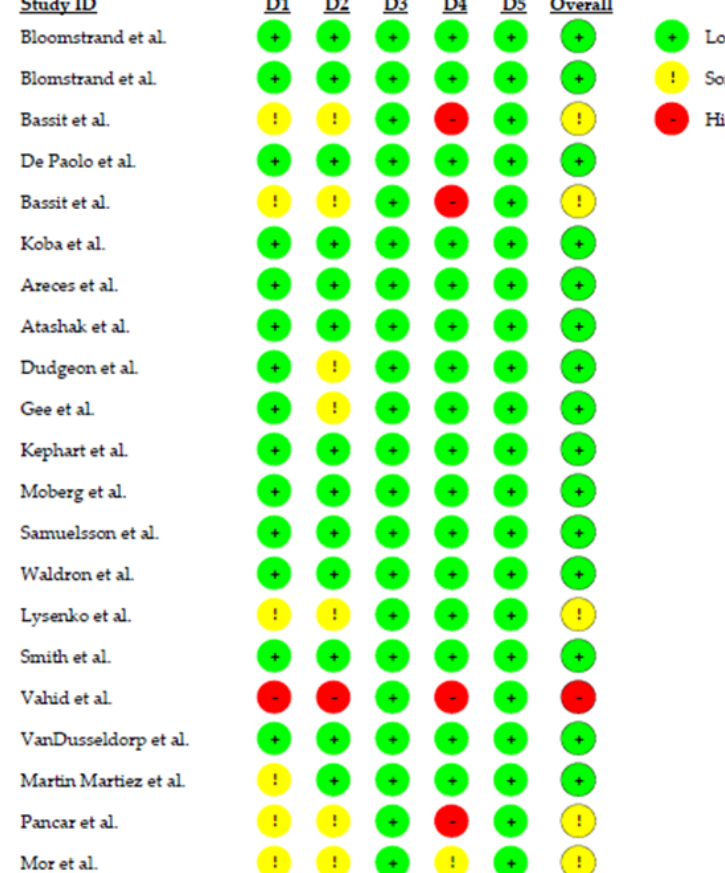
Figure 2. Risk of bias for each study [20,21,25–43] using the revised Cochrane risk of bias tool for randomized trials. D1: Bias arising from the randomization process, D2: Bias due to deviations from intended interventions, D3: Bias due to missing outcome data, D4: Bias in measurement of the outcome, D5: Bias in selection of reported results.